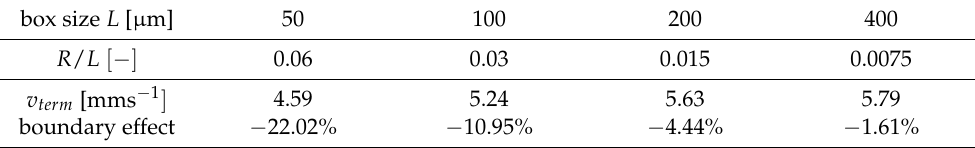
Table 2. Boundary effects—relative deviation of terminal velocity from theoretical